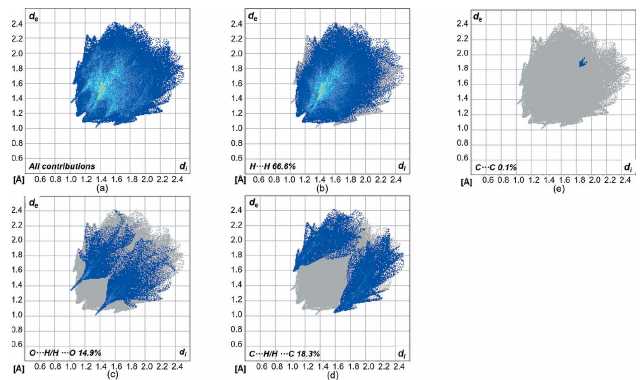
Figure 9 ( a ) Two-dimensional fingerprint plots of compound 2 , showing all contributions, and delineated ( b )–( e ) showing the contributions of atoms within specific interacting pairs (blue